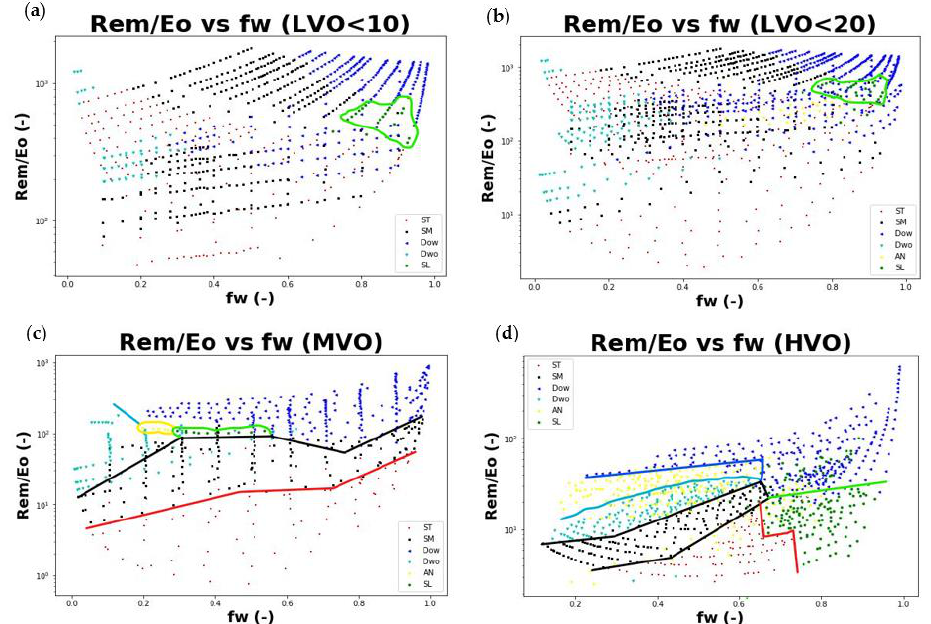
Figure 7. The ratio mixture Reynolds number to Eötvös number (Re m / Eo) versus water fraction (f w ), ( a ) < 10 mPa s ( b ) < 20 mPa s ( c ) 20–100 mPa · s, ( d ) > 100 mPa s, for the gathered published experimental datasets. Note: data points denoted with red squares, black rectangles, blue triangle_left, cyan triangle_down, yellow circle and green star represent stratified flow (ST), stratified mixed flow (SM), dispersed oil-in-water flow (Do / w), dispersed water-in-oil flow (Dw / o), annular flow (AN) and slug flow (SL), respectively. Each boundary line denoted with red, black, blue, cyan, yellow and green encloses—partially or completely—stratified flow (ST), stratified mixed flow (SM), dispersed oil-in-water flow (Do / w), dispersed water-in-oil flow (Dw / o), annular flow (AN) and slug flow (SL), respectively.